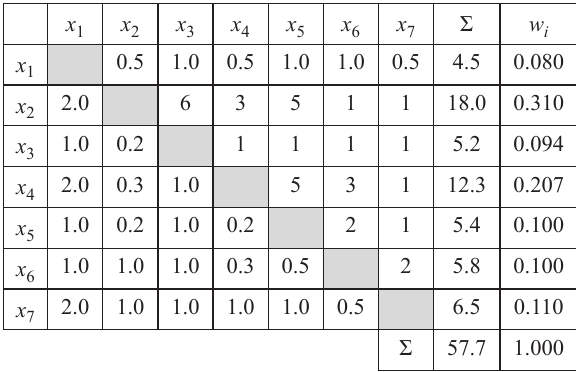
Table 1. The pair-wise comparison of criteria weights ( w 1 , w 2 , w 3 , w 4 , w 5 , w 6 , w 7